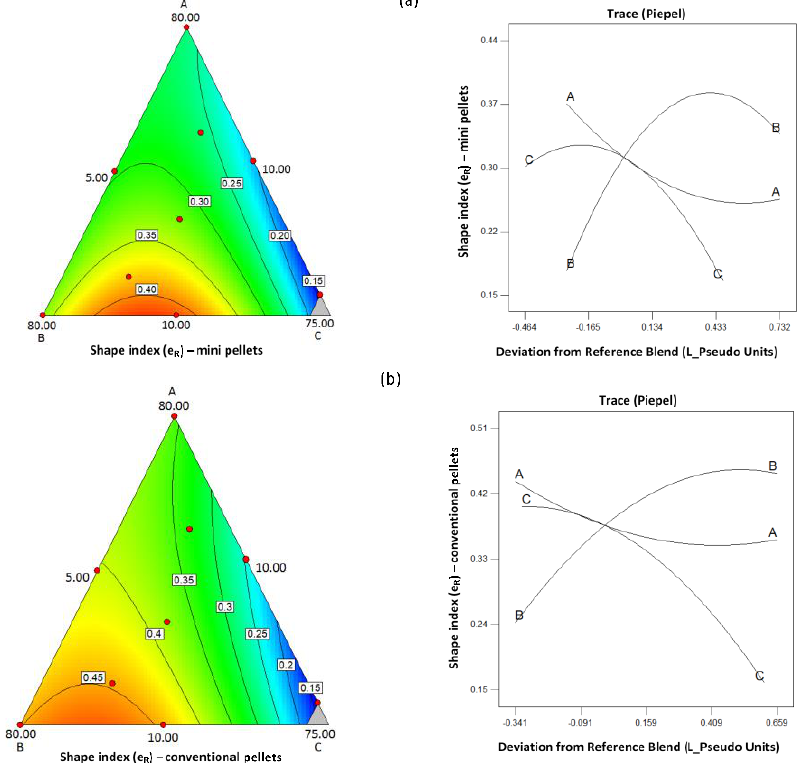
Figure 4. Contour and trace plots of the shape index e R for ( a ) mini and ( b ) conventional pellets.